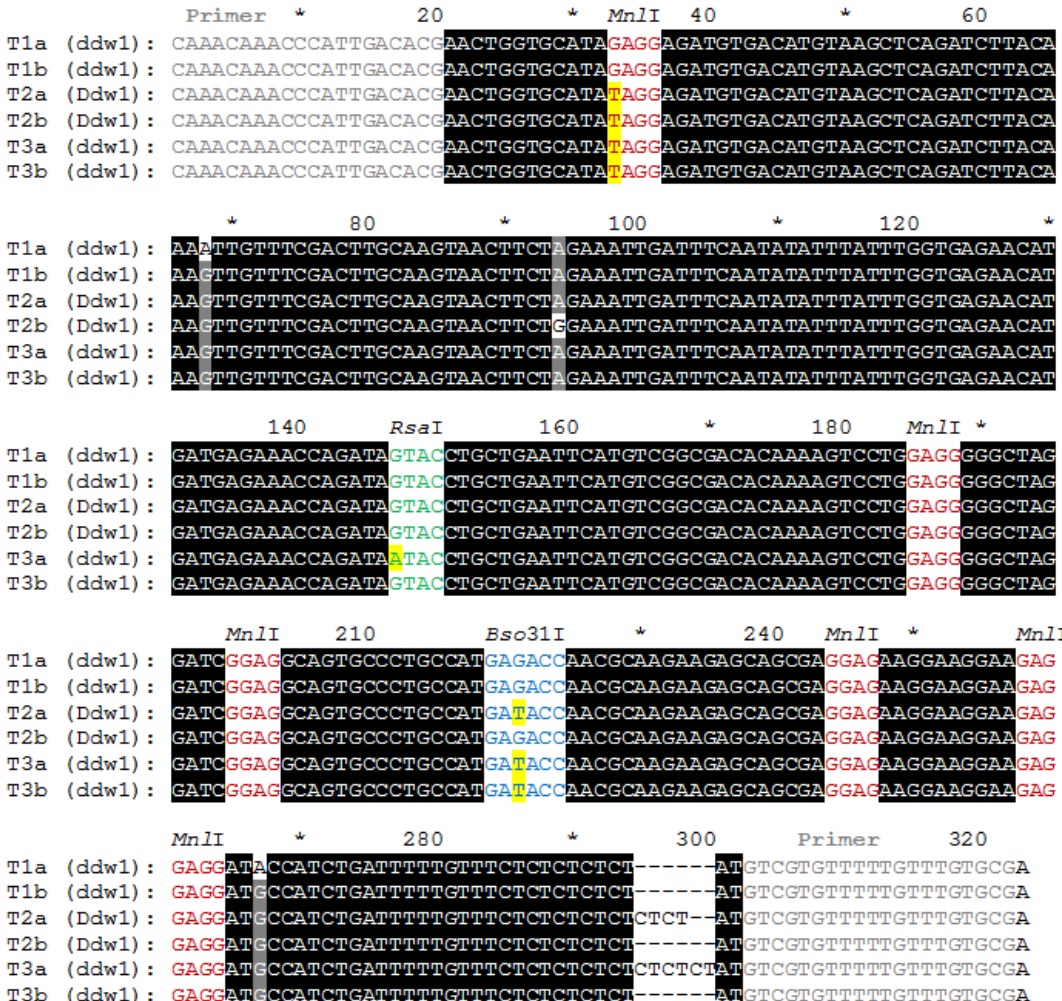
Figure 2. Multiple alignment for sequences obtained from the cloned REMS1218 PCR products. T1a, T1b are two sequences for Type 1 PCR product pattern ( ddw1 ), T2a, T2b are two sequences for Type 2 PCR product pattern ( Ddw1 ), and T3a, T3b are two sequences for Type 3 PCR product pattern ( ddw1 ). Restriction sites for endonucleases Mnl 1 (GAGG), Rsa I (GTAC) and Bso 31I (GAGACC) are highlighted. Primer sequences are shown in grey.